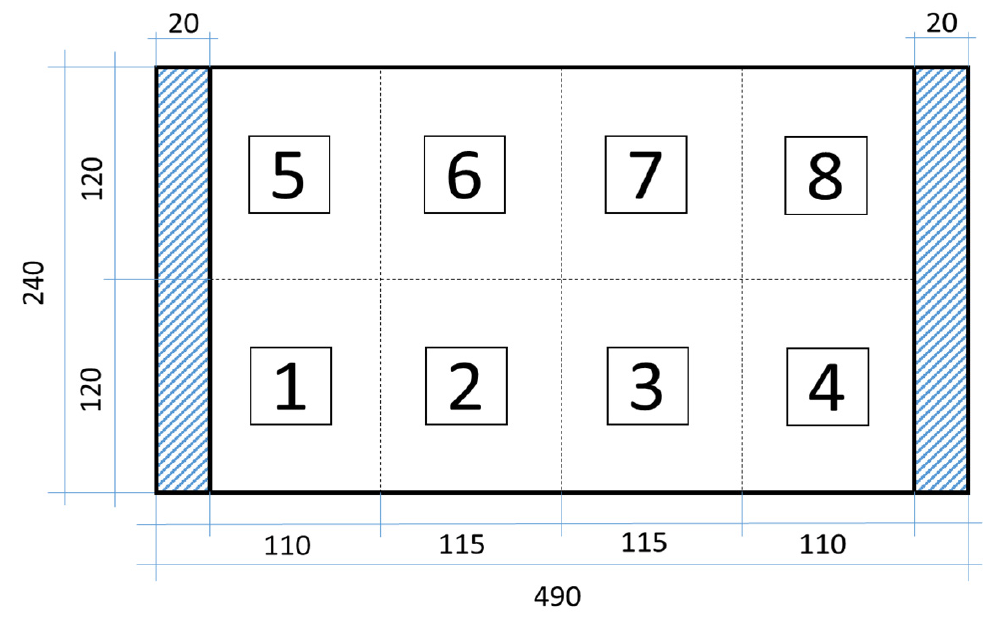
Figure 24. CFRP plate with substructures for damage localization.